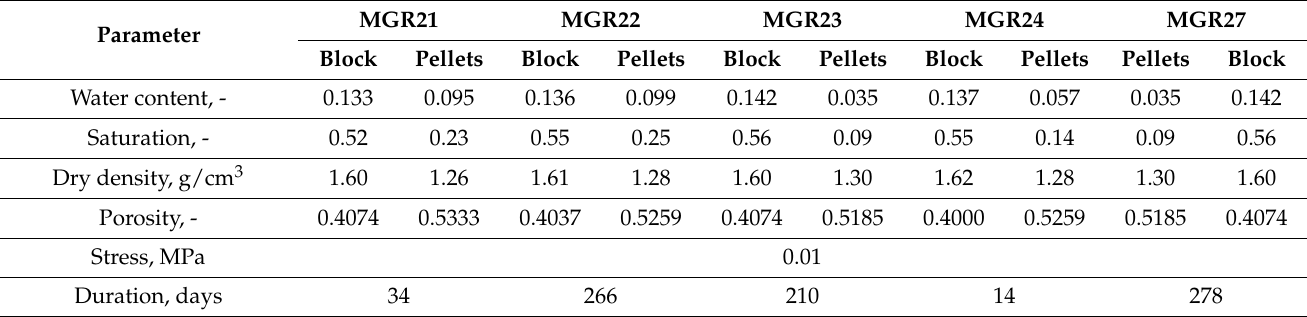
Table 3. The initial characteristics of the bentonite block and pellets and duration of each modeled case.